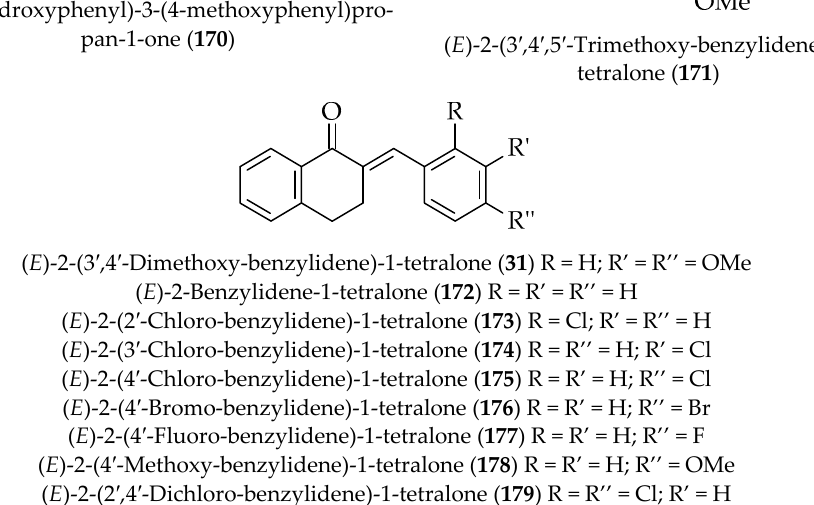
Figure 15. Structures of some synthetic antifungal chalcones. Gupta et al. [100] synthesized 10 chalcone derivatives ( 31 , 171 – 177 ) (Figure 15) and tested for their antifungal properties. None of these chalcones were active against A. niger and C. albicans , but showed strong fungicidal activity (MIC = 1.5 – 50.0 μ g/mL) against the dermatophyte Microsporum gypseum . It is noteworthy that ( E )-2-benzylidene-1-tetralone ( 172 ) and ( E )-2-(4 ′ -chloro-benzylidene)-1-tetralone ( 175 ) exhibited better antifungal activ- ity than the positive control ketoconazole, a well-known antifungal drug. It appeared that